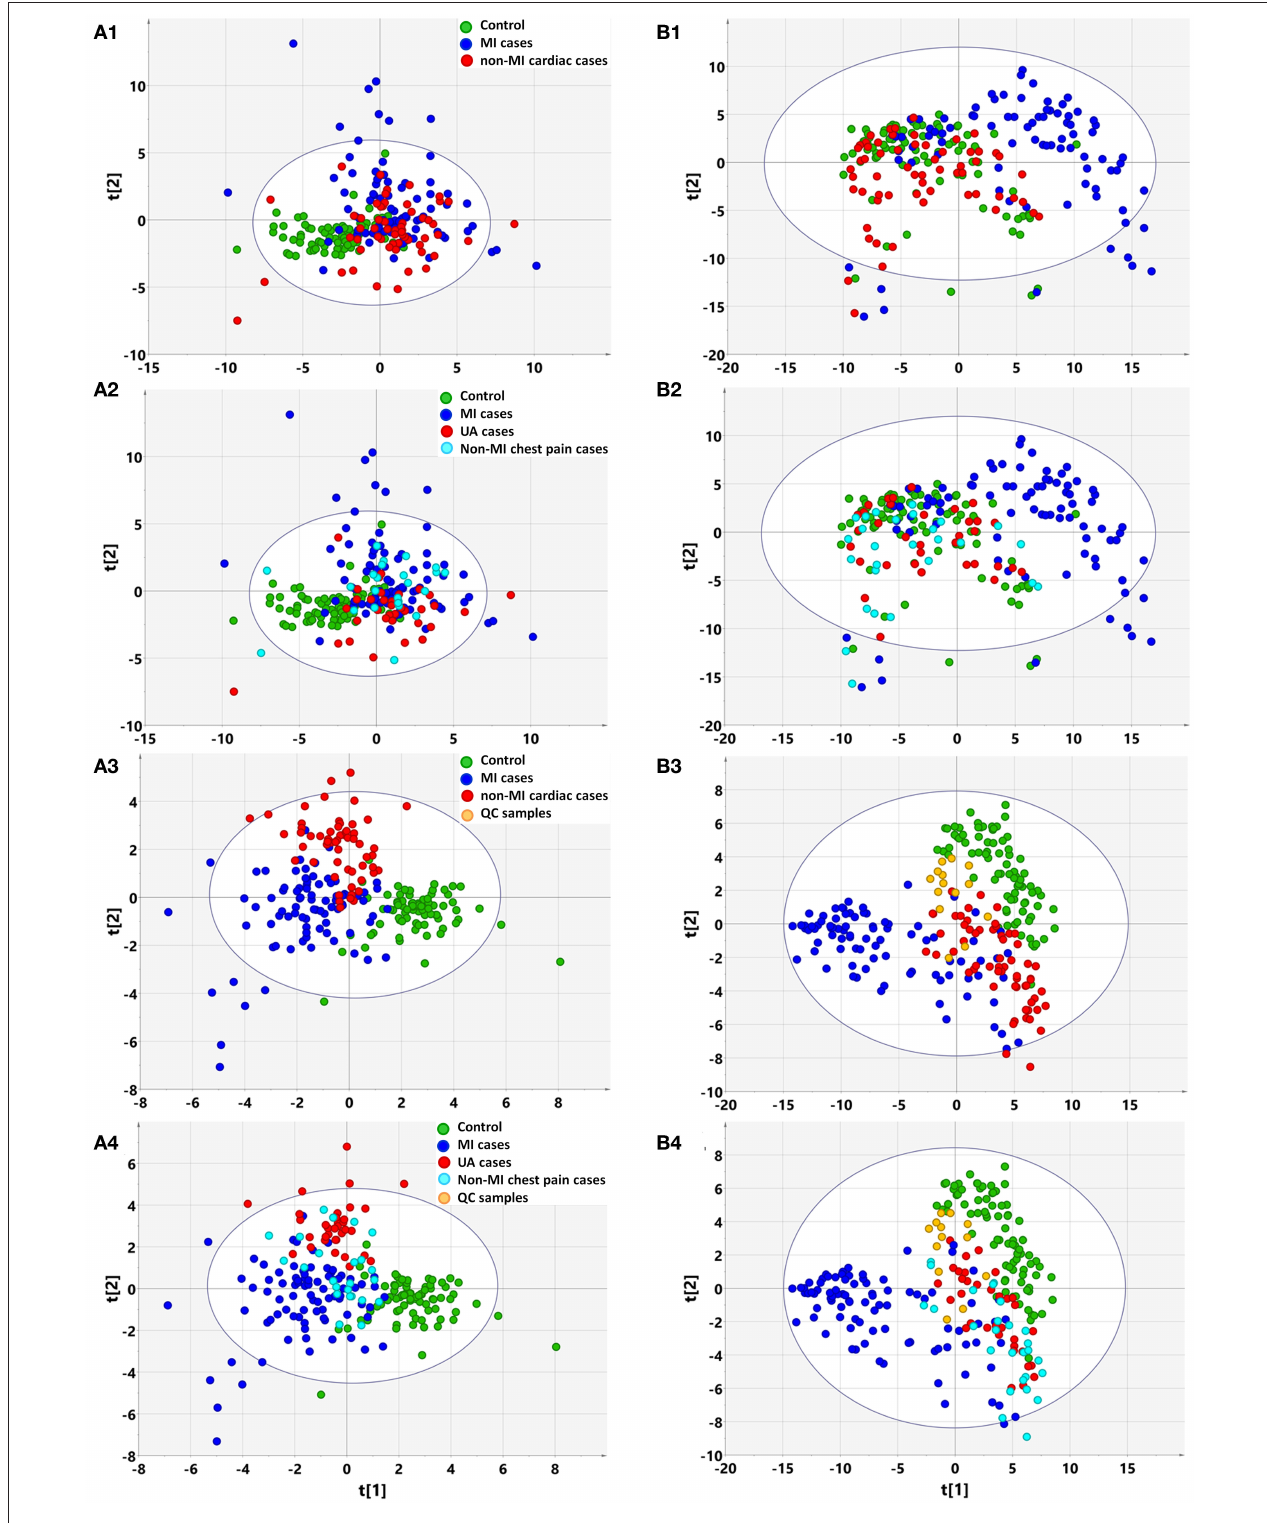
FIGURE 1 | Multivariate statistical analysis differentiates the groups of myocardial infarction (MI) cases, non-MI chest pain cases, and controls based on clinical information (A) and metabolomic data (B) , respectively. (1) Non-supervised PCA modeling displays the original similarity of the three groups: MI cases ( n = 85), non-MI chest pain cases ( n = 61), and controls ( n = 84), without arbitrary grouping. (2) Non-supervised PCA modeling displays the original similarity of the four groups: MI